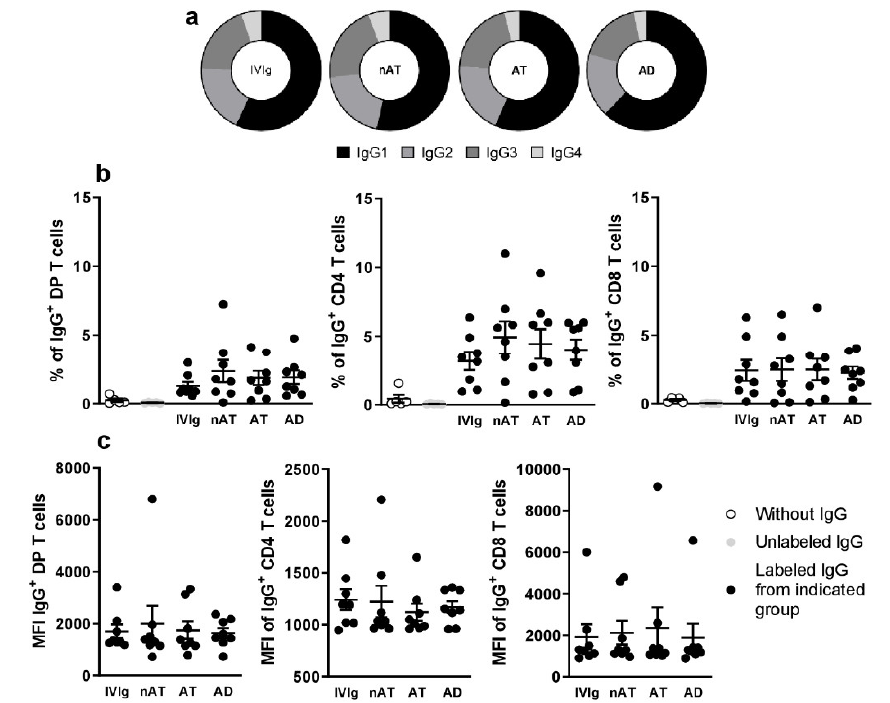
Figure 2. Evaluation of IgG isotypes frequency and the direct interaction with thymic T cells. The frequency of IgG1, IgG2, IgG3, and IgG4 isotypes was evaluated in all purified IgG pools ( a ). Thymocytes from children under seven days old (n = 8) were incubated for 30 min with labeling kit reagents (without IgG), unlabeled IgG, labeled IVIg, labeled nAT IgG, labeled AT IgG, or labeled AD IgG. The frequency ( b ) and intensity ( c ) of IgG staining (IgG+) on thymic T cells were demonstrated. Pie charts represent the frequency of each IgG isotype within the total amount of detected IgG. Each dot represents the value obtained from a different thymus. Bold lines represent the mean ± standard error. The absence of markings indicates that there was no statistical difference between the evaluated groups ( p > 0.05).